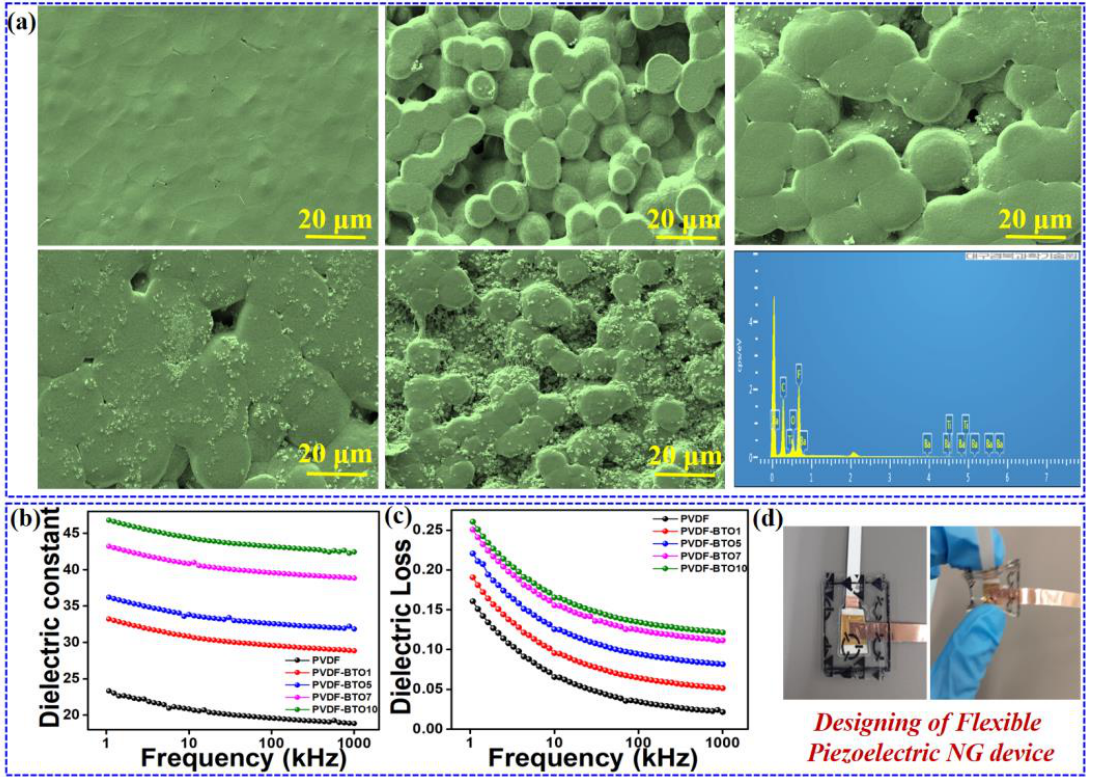
Figure 2. Properties of the PVDF-BTO composite films; ( a ) the surface morphology of pure PVDF and PVDF-BTO composite films (1, 5, 7, 10 wt%); the EDS spectra of the PVDF-BTO of 10wt% BTO into PVDF is examined, and all the elements match well with its chemical composition; ( b , c ) dielectric constant and dielectric loss of the pure PVDF and composite films; ( d ) the image of the flexible PNG10 piezoelectric nanogenerator device.